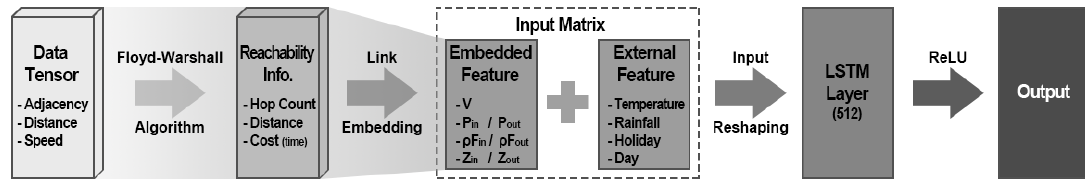
Figure 1. The overall procedure for traffic link embedding and training for traffic speed